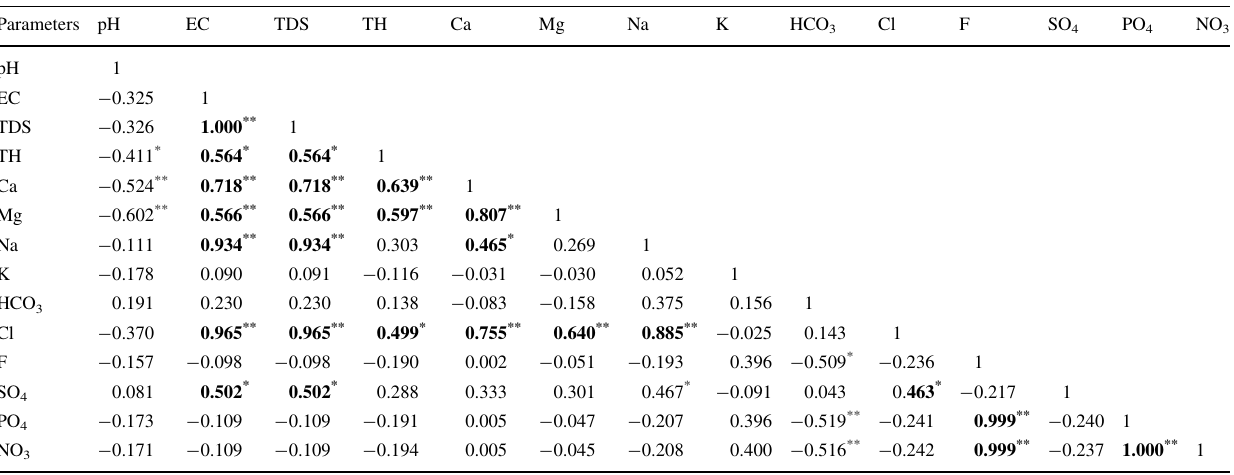
Table 5 Correlation coefficient matrix of major cations and anions of the study area—August 2013 Parameters